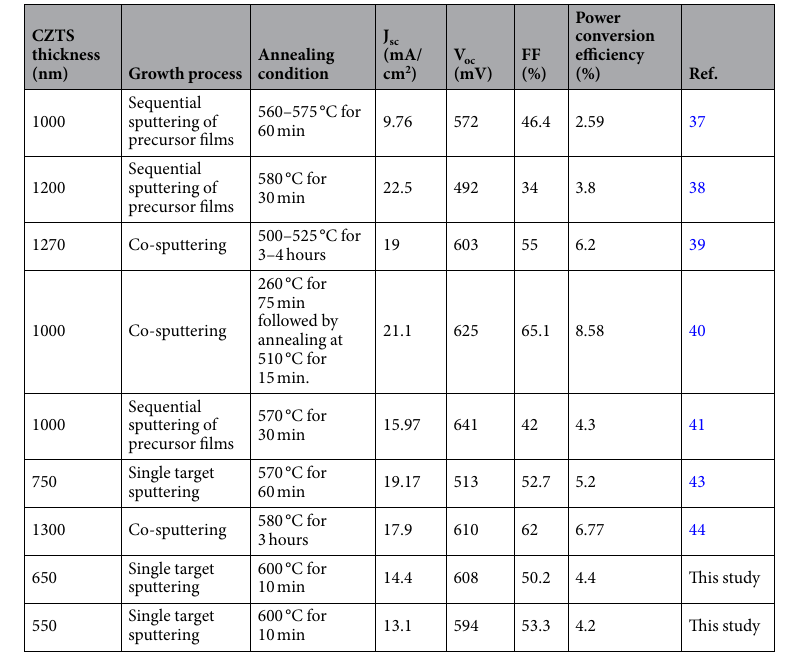
Table 4. Photovoltaic parameters of reported sputter grown CZTS thin film solar